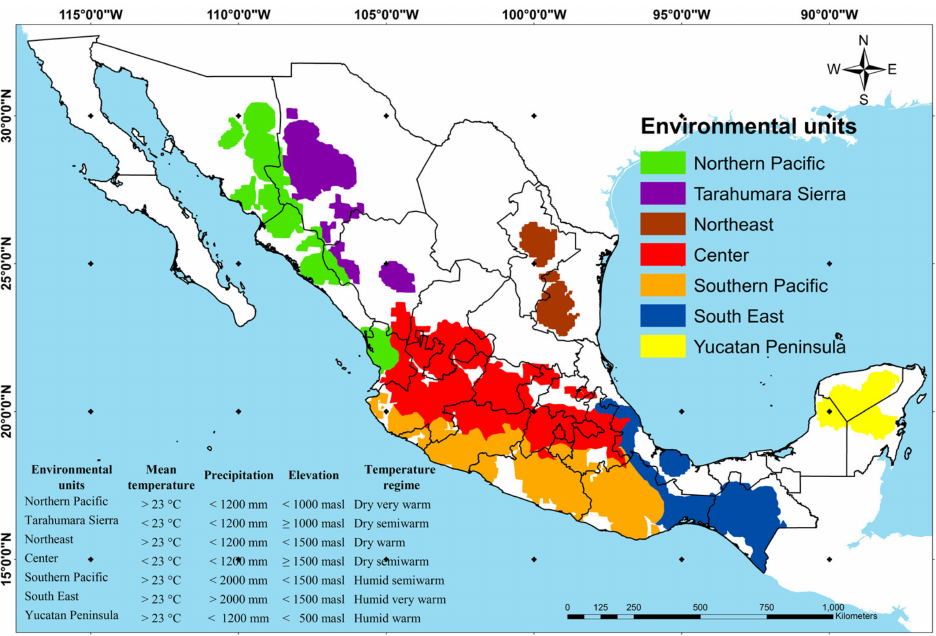
Figure 5. Spatial delimitation of the seven environmental units that were differentiated when characterizing the maize diversity center in Mexico by climatic